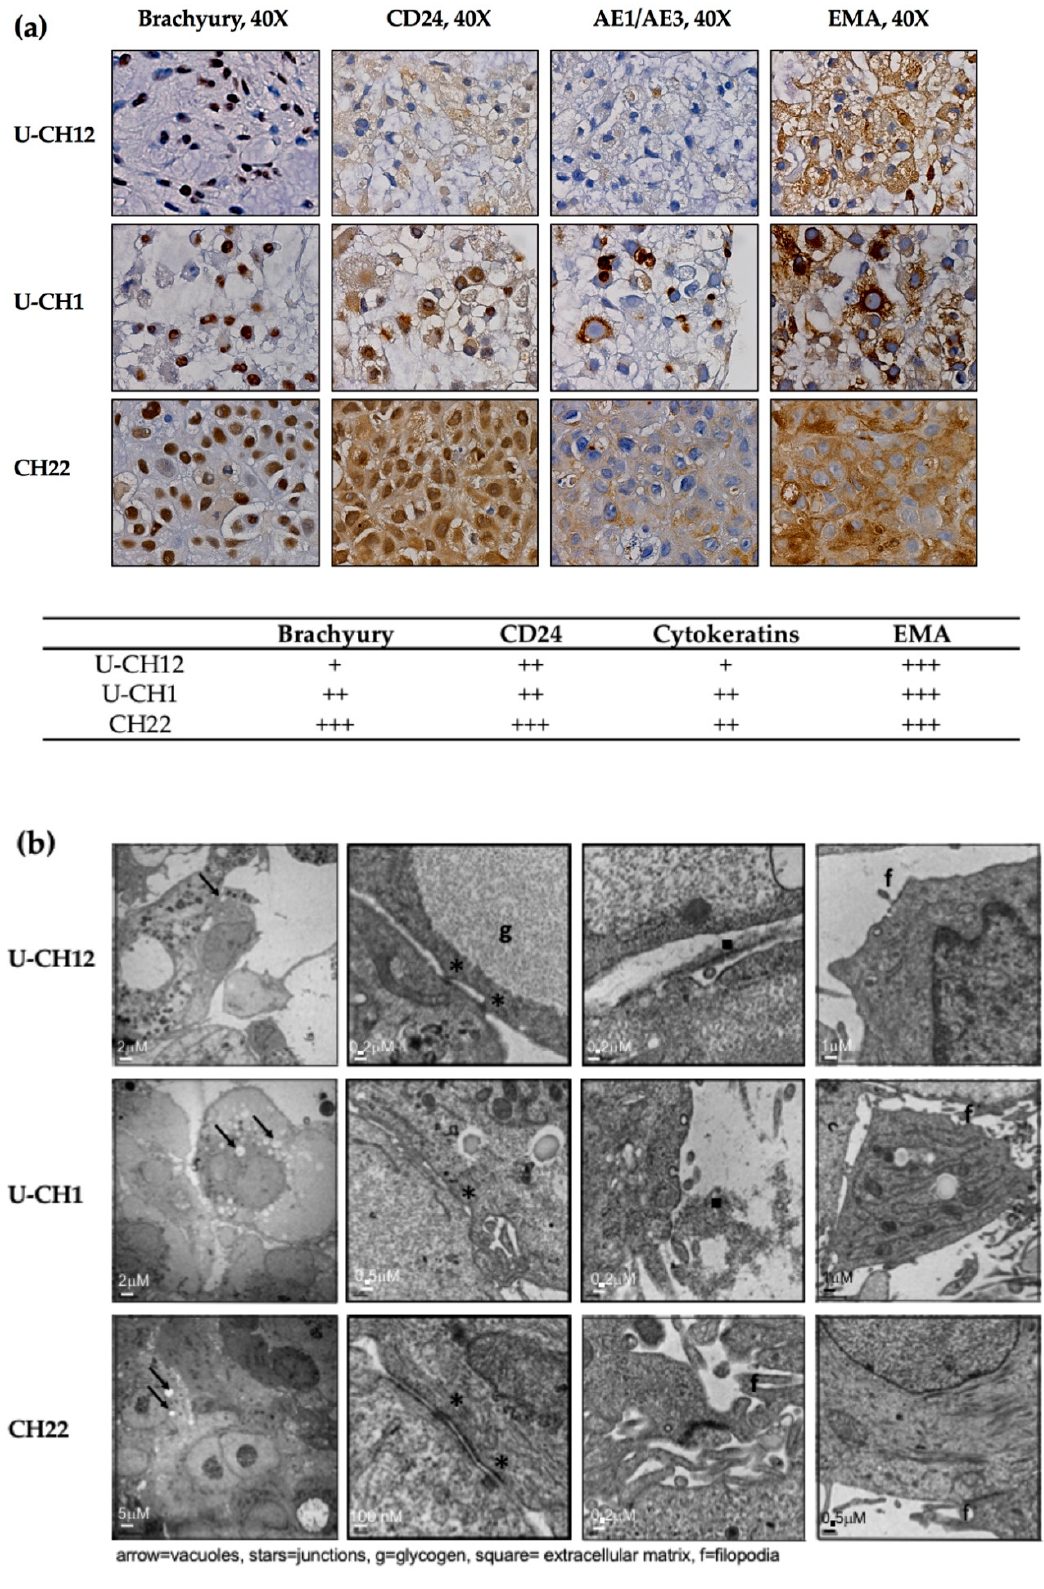
Figure 1. Chordoma spheroids recapitulate the main histological and morphological features of the disease: at 7 days of culture, ( a ) chordoma markers brachyury, CD24, cytokeratins AE1/AE3, and EMA (40 × objective) and their quantification were immunostained and ( b ) spheroid morphology was imaged by an electron microscopy. The arrows represent vacuoles, the stars represent junctions, the squares represent the extracellular matrix, f is the filopodia, and g is the glycogen